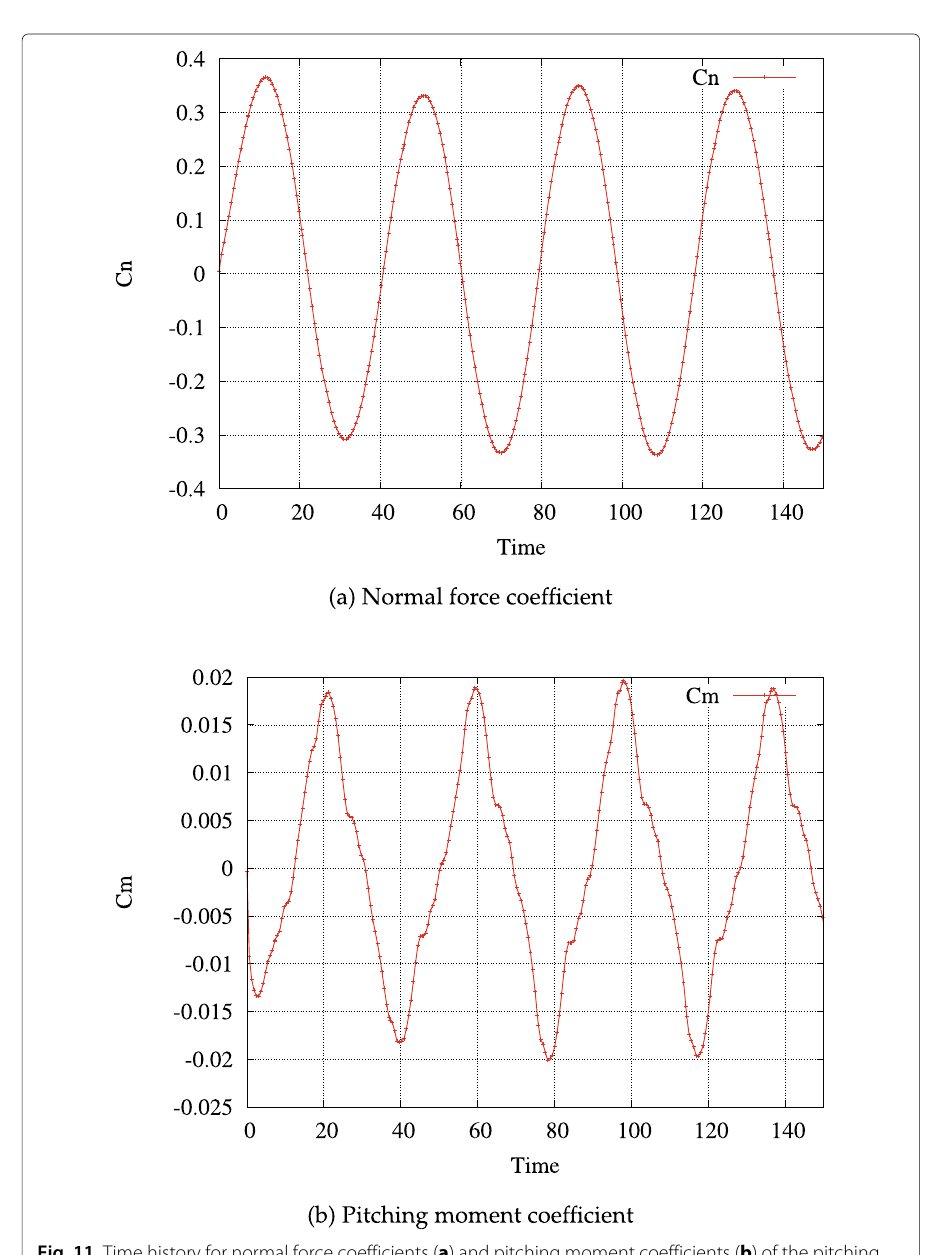
Fig. 11 Time history for normal force coefficients ( a ) and pitching moment coefficients ( b ) of the pitching NACA0012